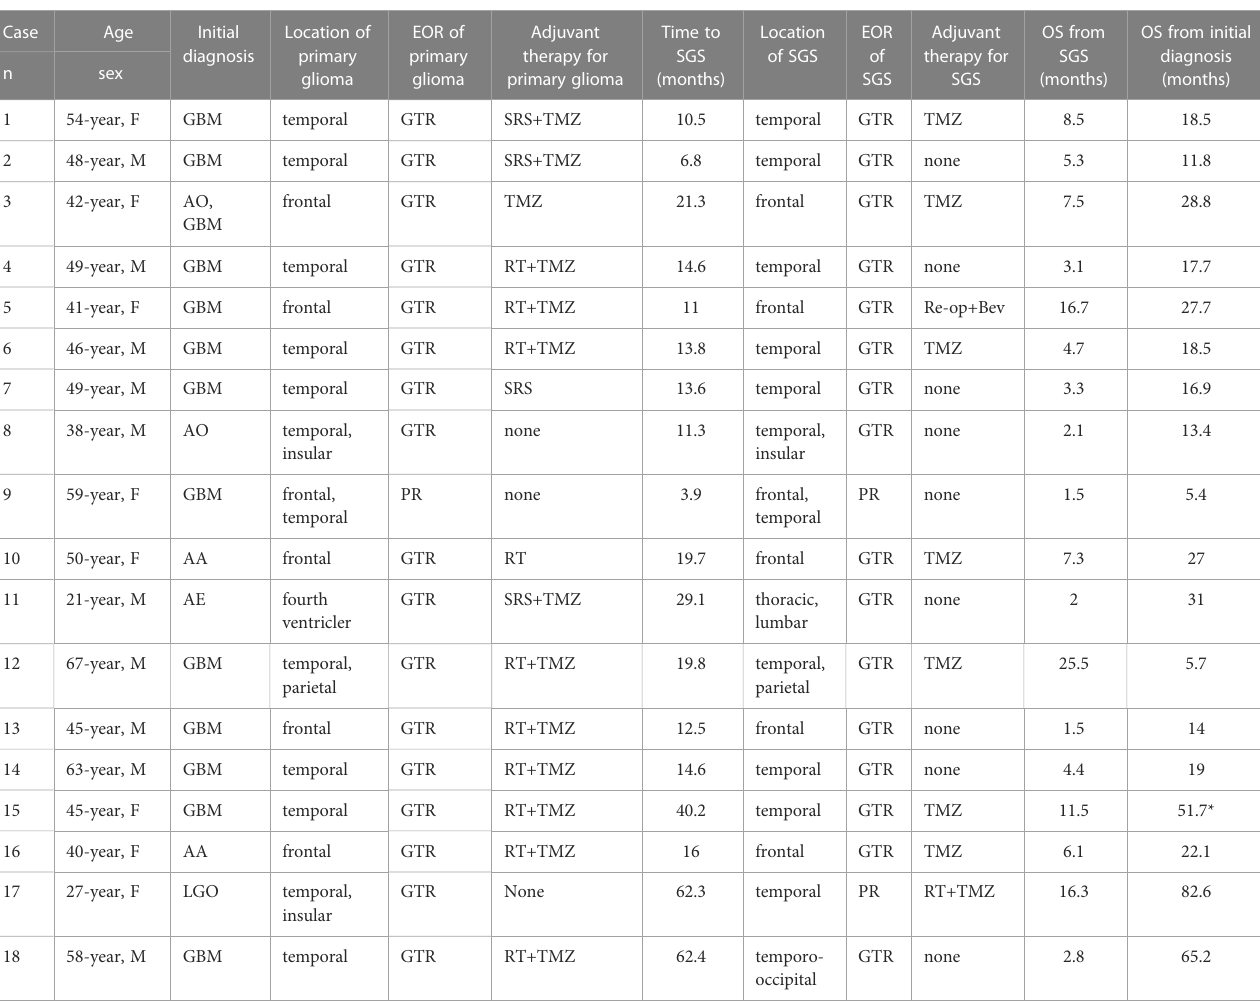
TABLE 1 Clinical data and outcomes of SGS patients in our